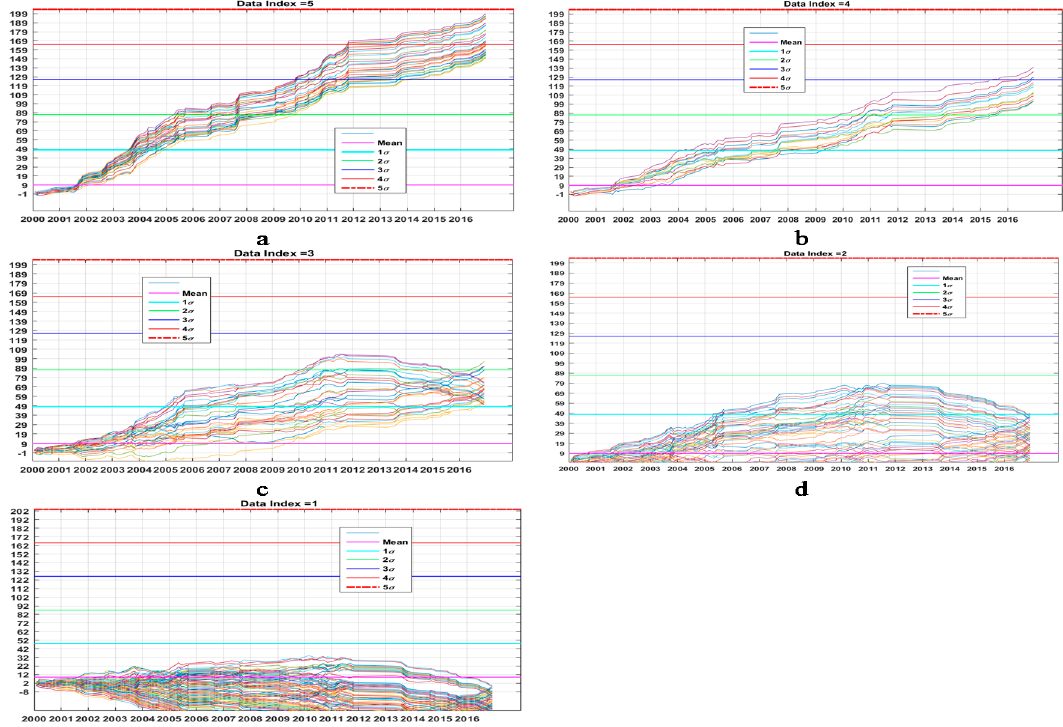
Figure 11. ( a , b , c ) I (5, 4, 3), respectively, showing an increasing trend; ( d ) I = 2; ( e ) I =